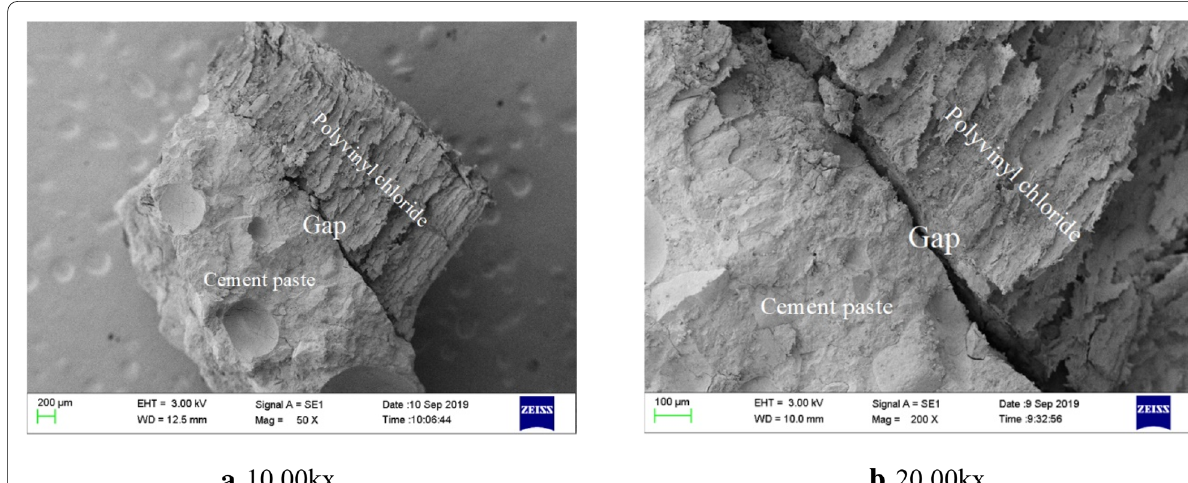
Fig. 7 Microstructure of CA30% at different magnification.